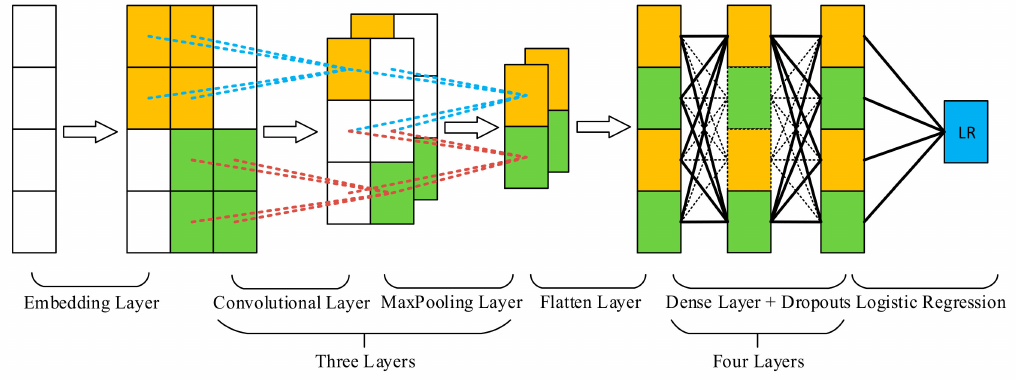
Figure 8. Illustration of the proposed improved CNN